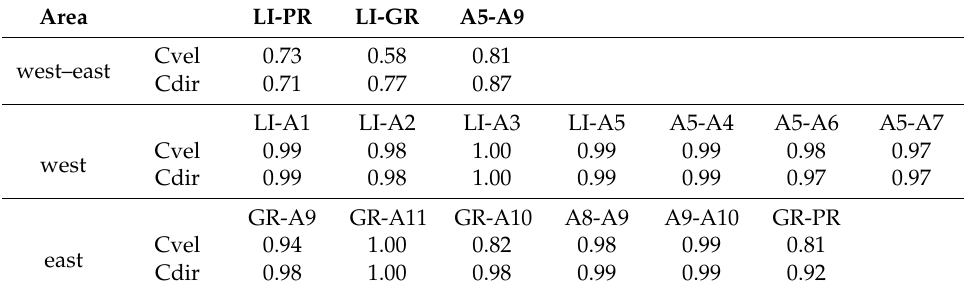
Table 1. Correlation coefficients for wind velocities (C vel ) and directions (C dir ) obtained by means the cross-correlation analyses between reconstructed anemometric data.